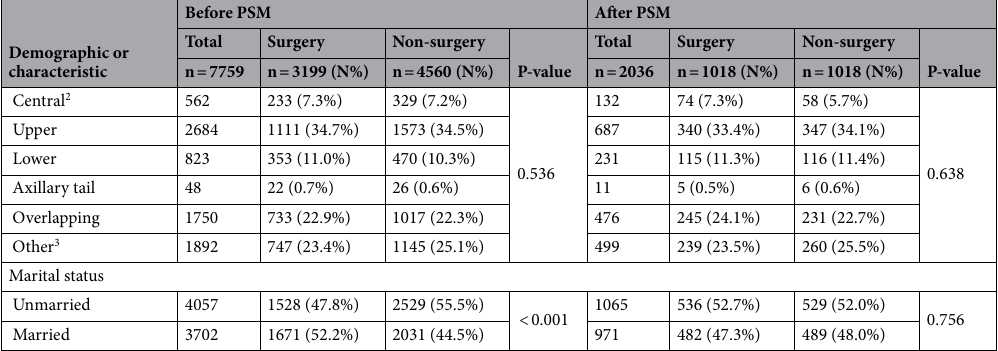
Table 1. The patient demographics and clinic-pathologic characteristics before and after PSM. *1: American Indian/AK Native, Asian/Pacific Islander; 2: central portion of breast or nipple; 3: Breast,NOS.